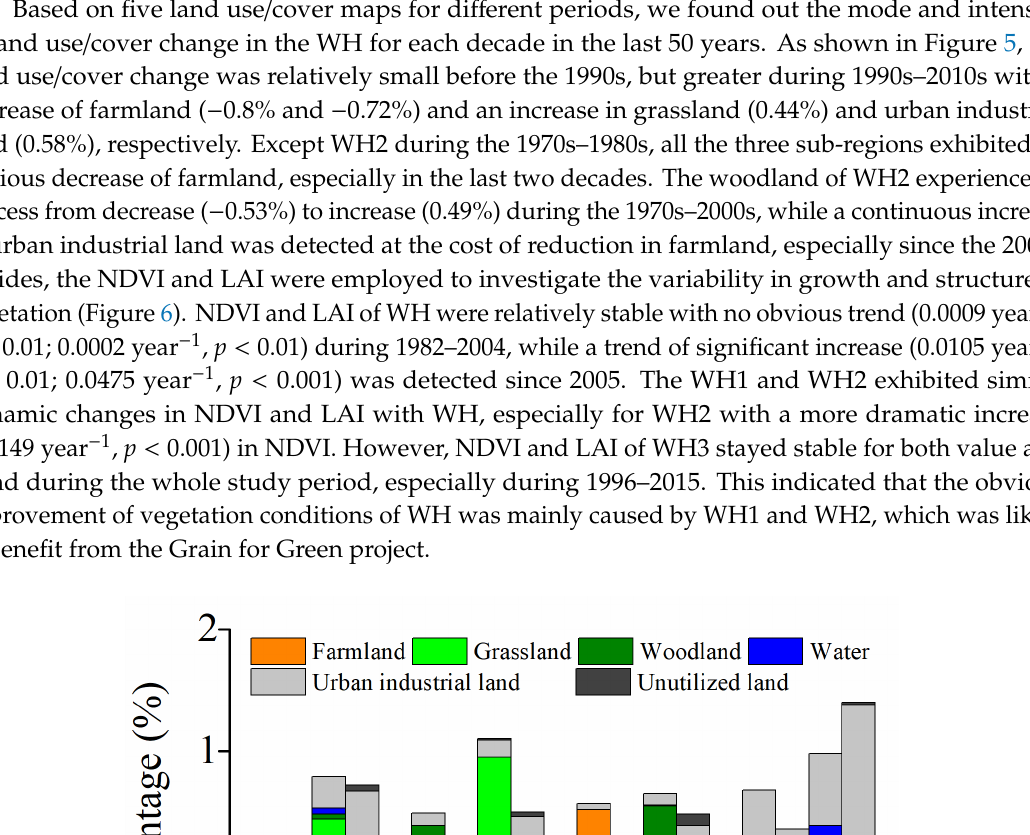
Figure 6. Annual mean satellite-estimated normalized difference vegetation index (NDVI) and leaf area index (LAI) over ( a ) the Weihe River basin (WH) and the three sub-regions, i.e., ( b ) WH1, ( c ) WH2, and ( d ) WH3, from 1982 to 2015. (* and ** represent 𝑝 < 0.01 and 𝑝 < 0.001 , respectively.) 4.4. Variability of Runoff during 1961–2016 Among the three sub-regions, the WH3, covering 30.82% of the WH contributed the most runoff with an average percentage about 54.48% of the total runoff during 1961–2016, followed by WH2 (25.15%) and WH1 (20.37%) (Figure S2), and this percentage showed an increasing trend especially since 1997. The results of the Pettitt test (Figure 7) showed that 1993 was the most probable change point of the observed runoff over the WH ( 𝑝 < 0.01 ), which could be speculated to be induced by human activity because no significant change-point in this period was detected in both precipitation and potential evapotranspiration. The runoff of the three sub-regions was also found to have